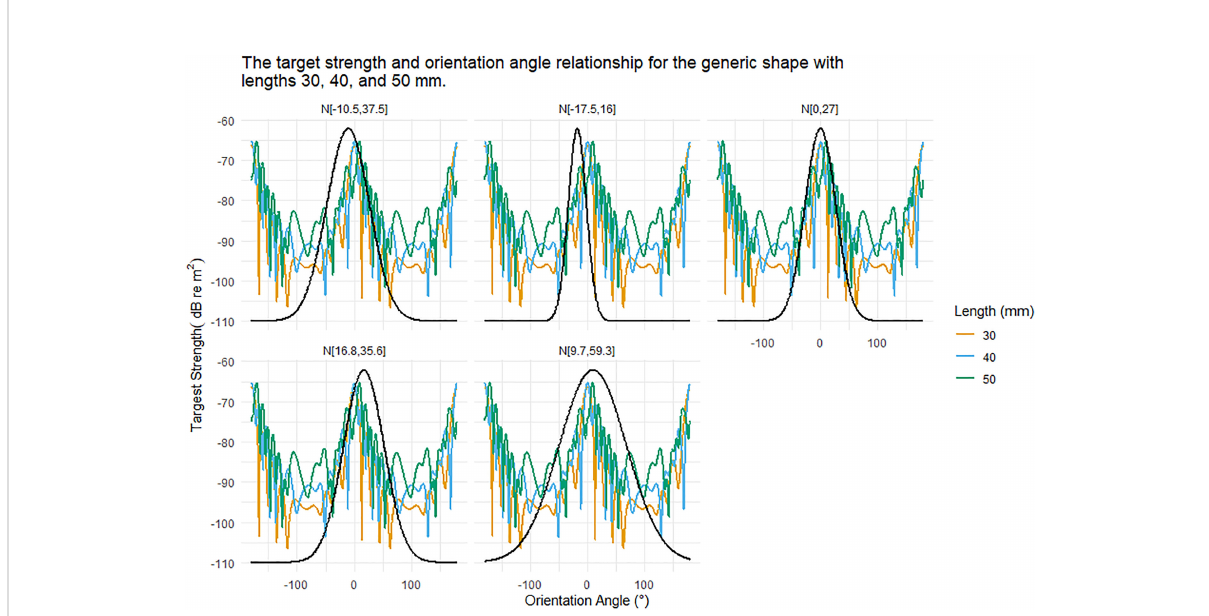
FIGURE 5 The relationship between target strength (TS) and orientation angle for the generic shape for krill of length 30, 40, and 50 mm is shown in each panel for reference. Each panel displays a different Gaussian orientation distribution N[theta,St.Dev] where theta is the mean orientation angle and St.Dev is the standard deviation. These orientation distributions are centred on or close to 0 degrees. The standard deviations range from 16 to 59.3 degrees. As the standard deviations increase the range of TS responses encompassed also increases, especially as nulls are